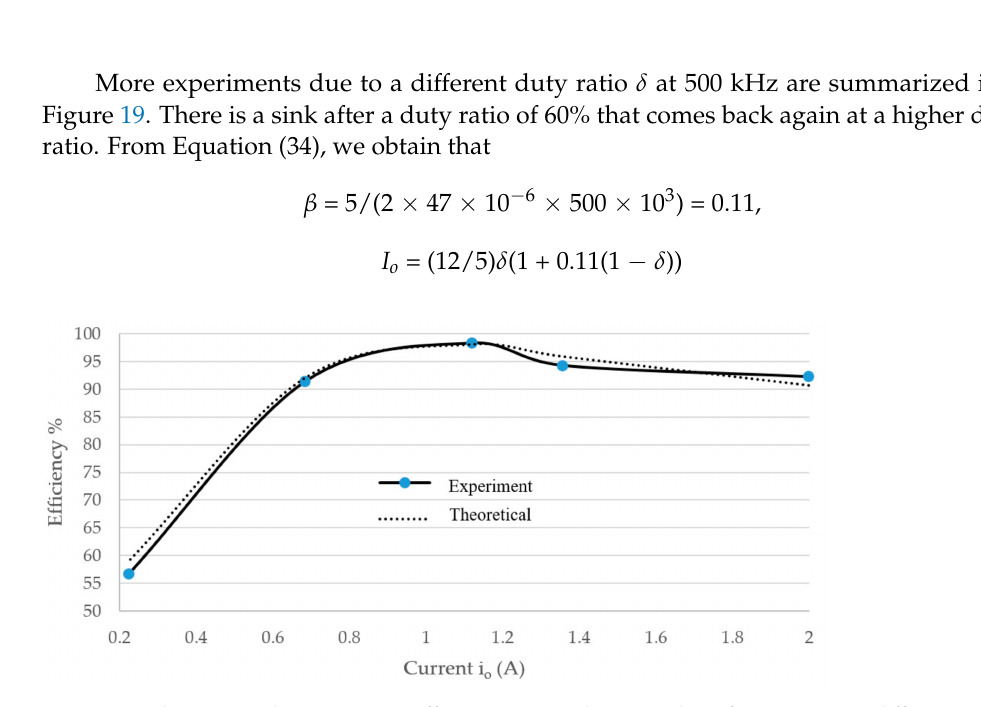
Figure 19. The P-Cascode GaN HEMT efficiency at a 500 kHz switching frequency vs. a different output current via duty control.